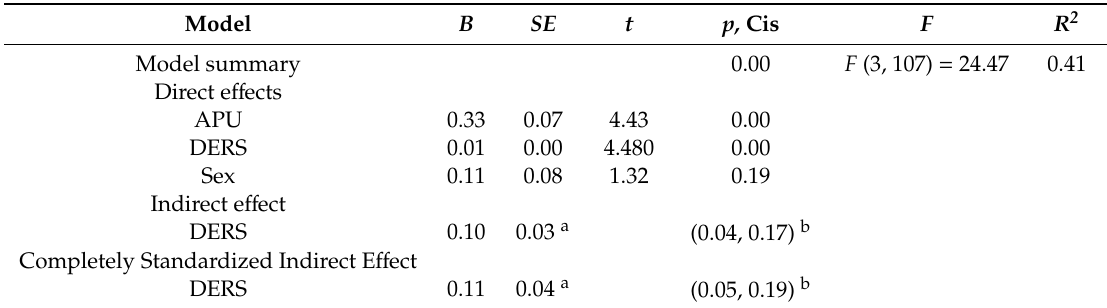
Table 3. Emotion Regulation Di ffi culties (DERS) as a Mediator of the Relation Between Addictive Phone Use (APU) and Dysregulated Eating.